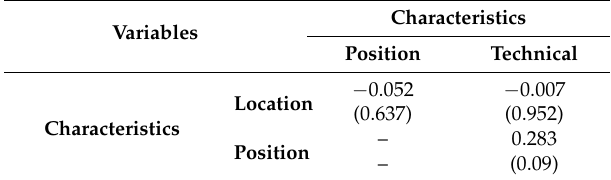
Table 3. Pearson correlations test of the touristic sample (85 cases; Sig. 2-code in